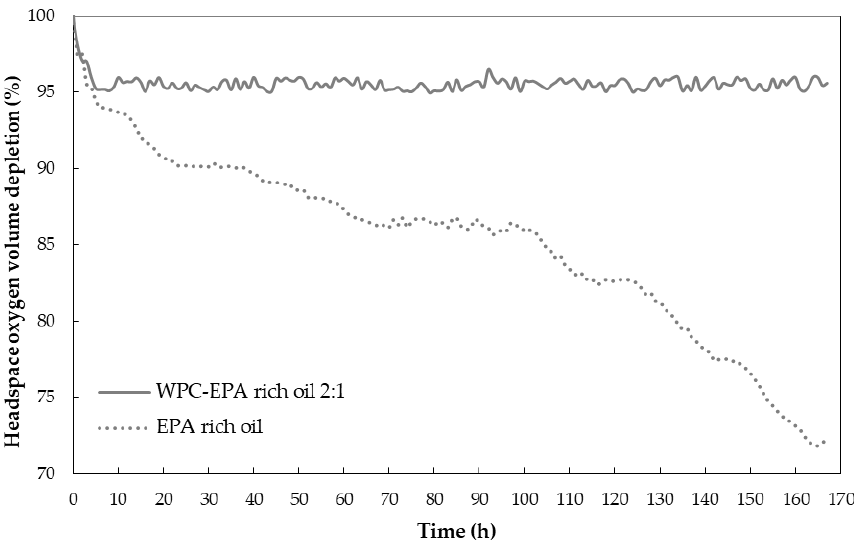
Figure 6. Comparison of the averaged headspace oxygen volume depletion between the neat oil and EPA-loaded WPC microparticles.